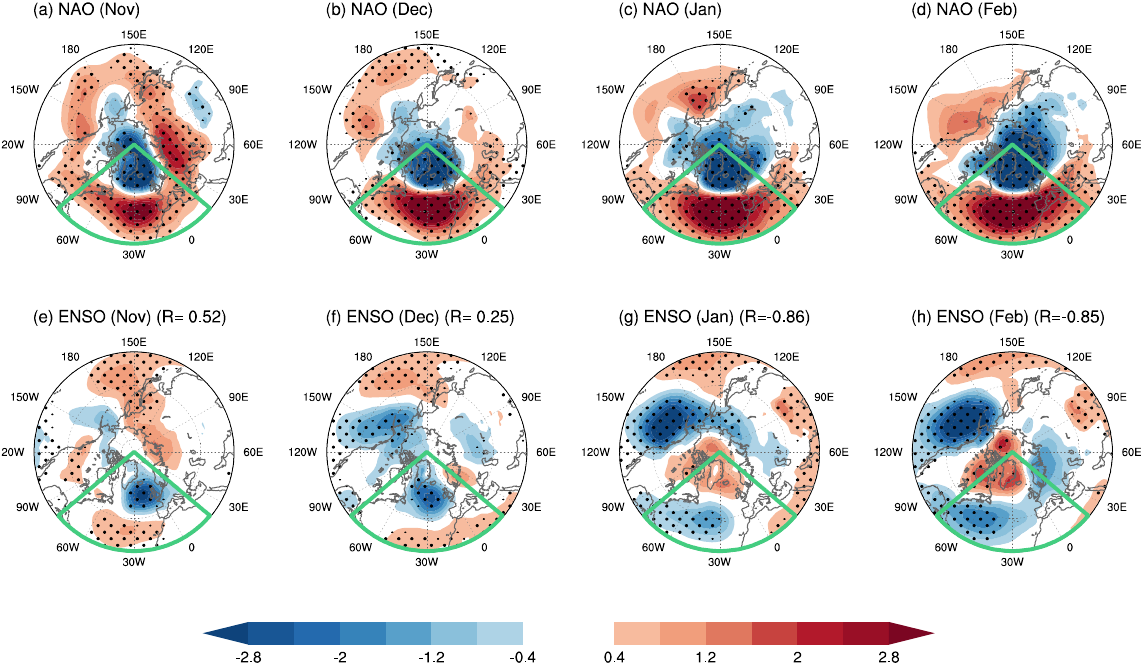
Figure 1. SLP anomalies (hPa) in ( a ) November, ( b ) December, ( c ) January, and ( d ) February re- gressed upon the simultaneous standardized NAO index. ( e – h ) Similar to ( a – d ) but for SLP anom- alies regressed on the Niño3.4 index. Large (small) dots indicate regression coefficients that are sta- tistically significant at the 95% (90%) confidence level. The green box indicates the North Atlantic region (20°–90° N, 0°–80° W). The pattern correlation is displayed in ( e – h ), which is calculated based on the NAO-related SLP anomalies and ENSO-related anomalies over the North Atlantic region for each month, respectively.